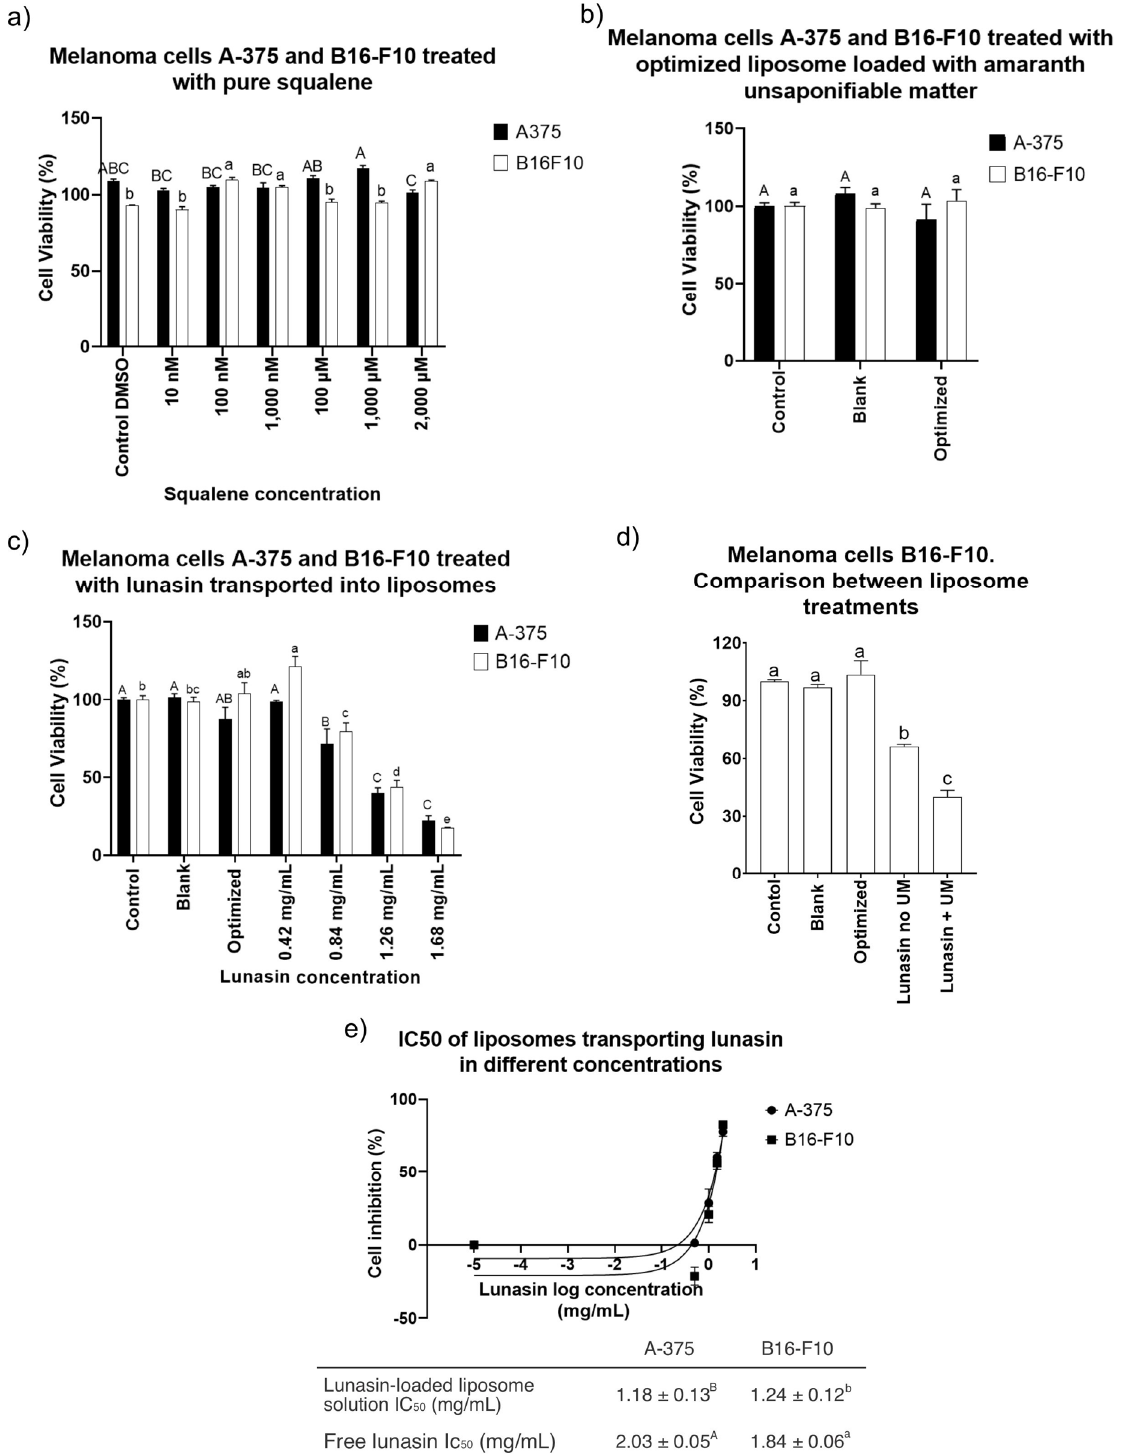
Figure 7. Cell viability assay performed with CCK-8 (2-(2-methoxy-4-nitrophenyl)-3-(4-nitrophenyl)-5-(2,4-disul- fophenyl)-2H-tetrazolium, monosodium salt) in both cell lines. ( a ) A-375 and B16-F10 cells treated with different concentrations of pure squalene dissolved in DMSO (<0.05%). ( b ) A-375 and B16-F10 cells treated with blank liposomes prepared